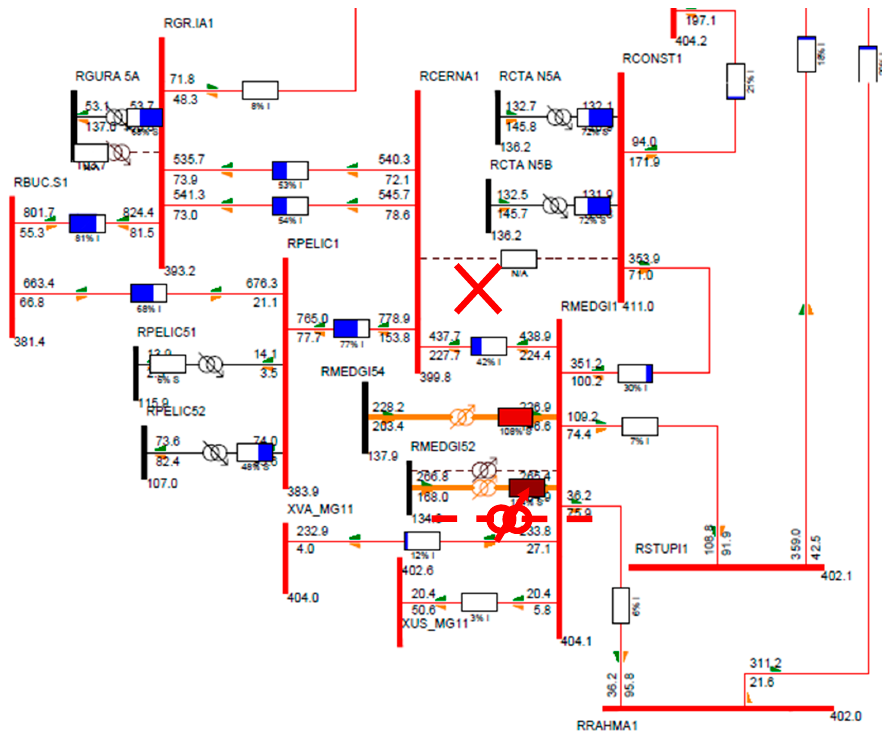
Figure 7. Unavailability of a 400 kV line determining the overloading of transformers.